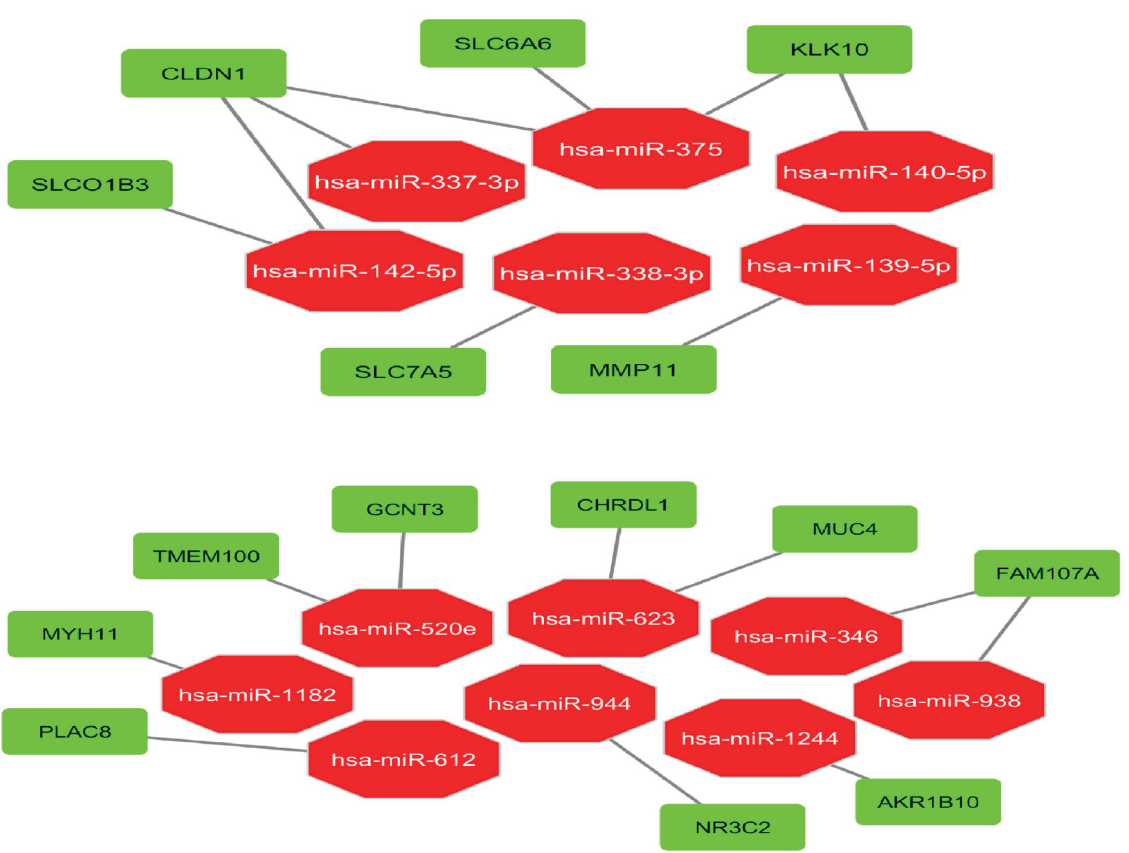
Fig 14. Interactions between Differentially Expressed miRNAs and their target validated Differentially Expressed Genes (vDEGs-DEMs). Top) Over-expressed vDEGs- down-regulated DEMs. Bottom) Under-expressed vDEGs- up-regulated DEMs.